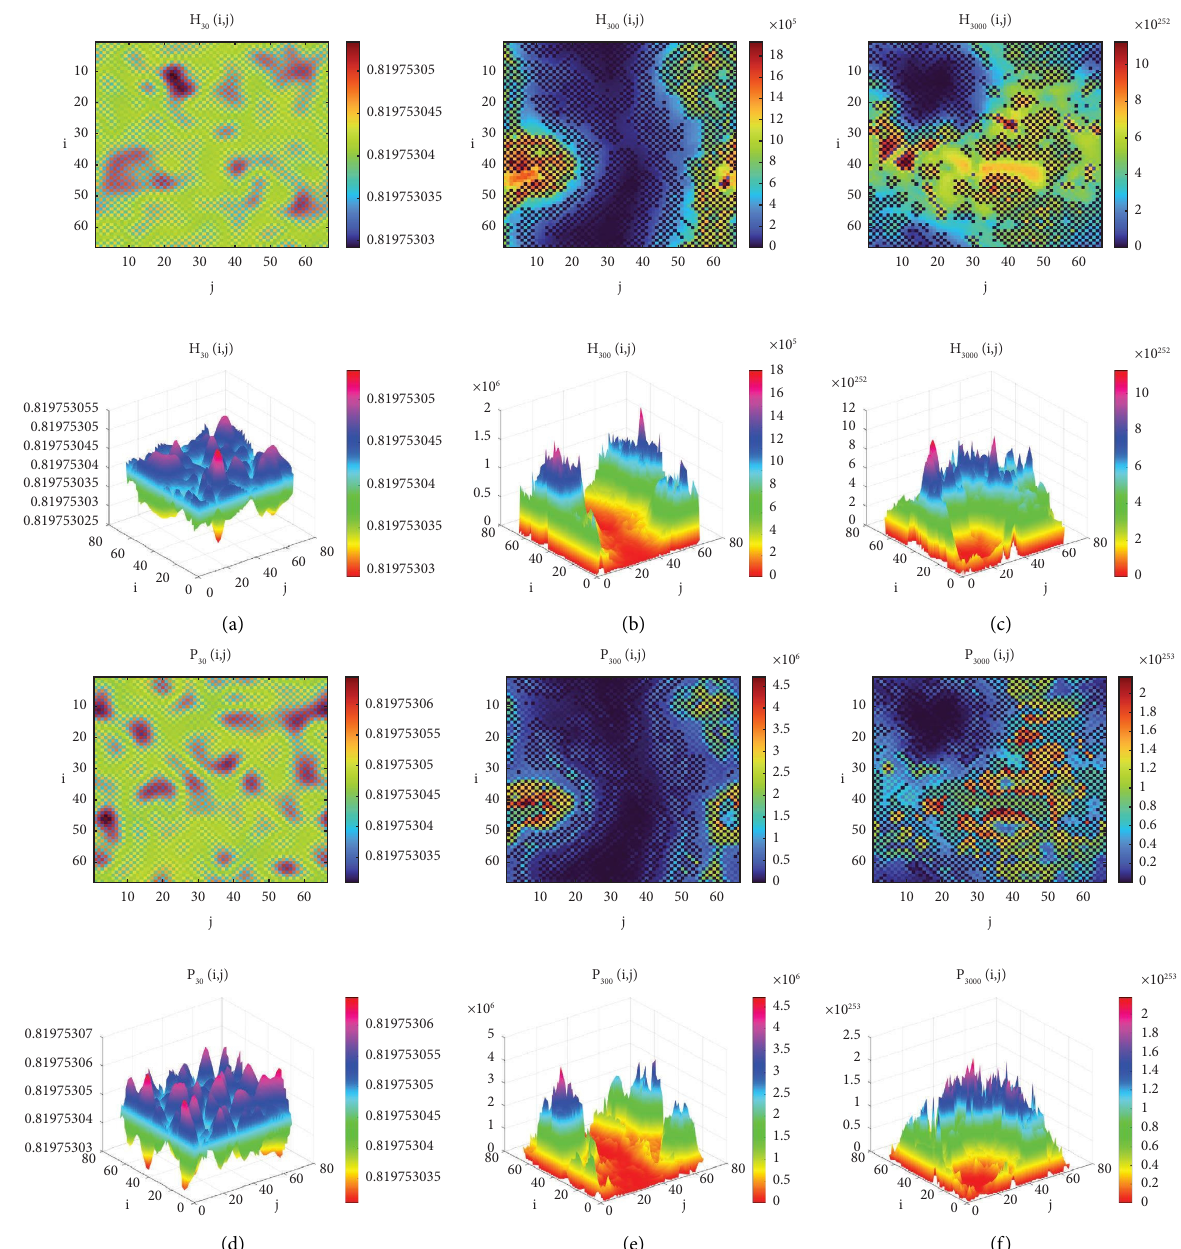
Figure 28: R � 2 , k � 1, c � 0 . 8, σ ∗ � 0 . 278655, σ � σ ∗ , ( d the case of Corollary 3(10), the Neimark-Sacker-Turing instability occurs, parasite and host populations exhibit an unstable state in two- dimensional